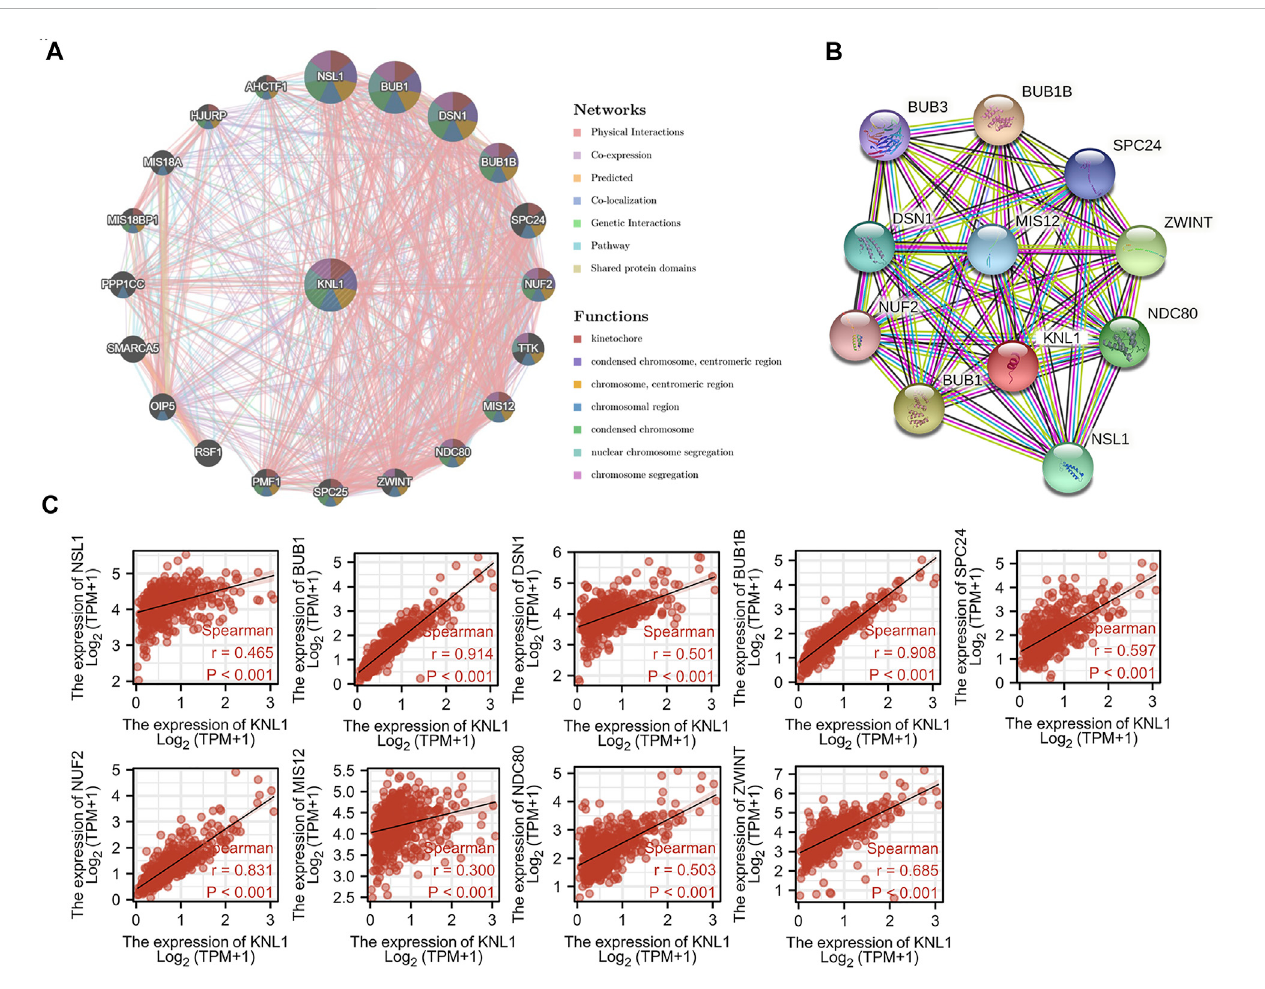
FIGURE 4 Co-expression genes of KNL1. (A) Network of the top 20 genes associated with KNL1 in GeneMANIA. (B) STRING. (C) Correlation analysis of KNL1 and its co-expressed genes.